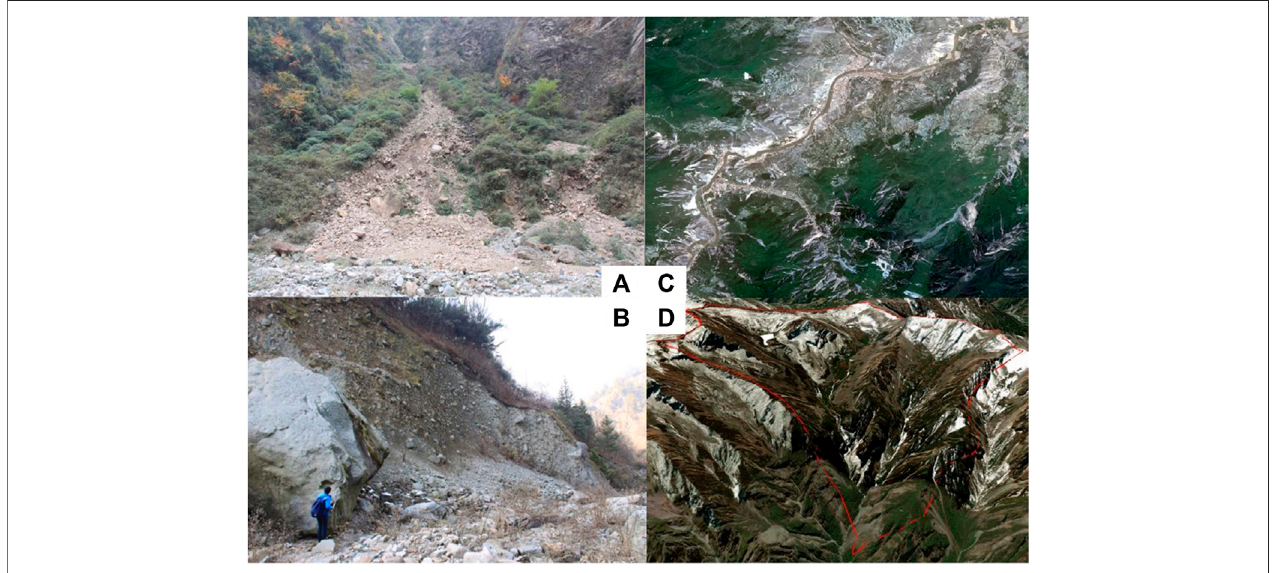
FIGURE 3 | Field investigation and remote sensing images in Qipangou valley (A,B) photography of Qipangou valley (C,D) Ikonos images and UAV images of Qipangou valley.